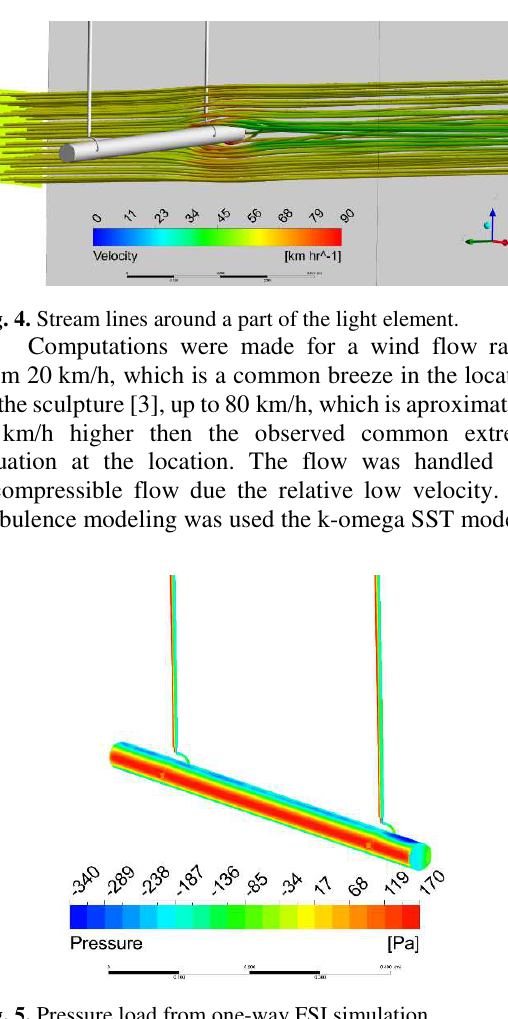
Fig. 5. Pressure load from one-way FSI simulation. A representative result from the computation shows fig. 6. The geometrical deformation scaling is overestimated for the evaluation but the red color shows the correct maximum deformation eq. deflection of 12.4 mm. To get a wind-velocity, deflection dependence few points were computed and result in a plot in fig. 7. Like expected the dependence of deflection is aproximately quadratic on the wind velocity. It is given simply due to the fact that pressure is lineary dependent on the flow stream energy but the energy of the flow is quadraticaly dependent on the